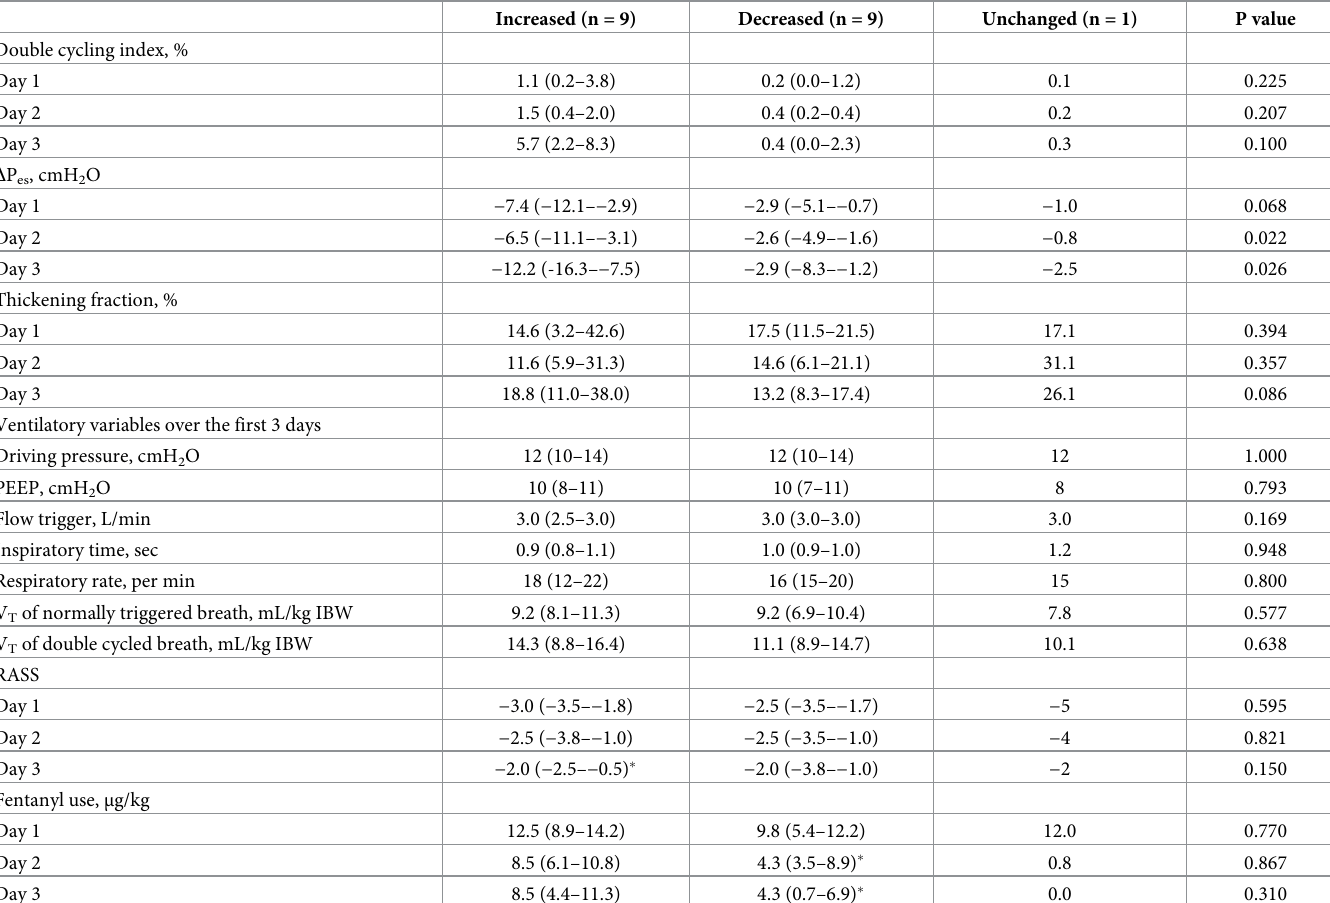
Table 2. Variables of double cycling, inspiratory effort, ventilation, and sedation status within the first 3 days of mechanical ventilation.